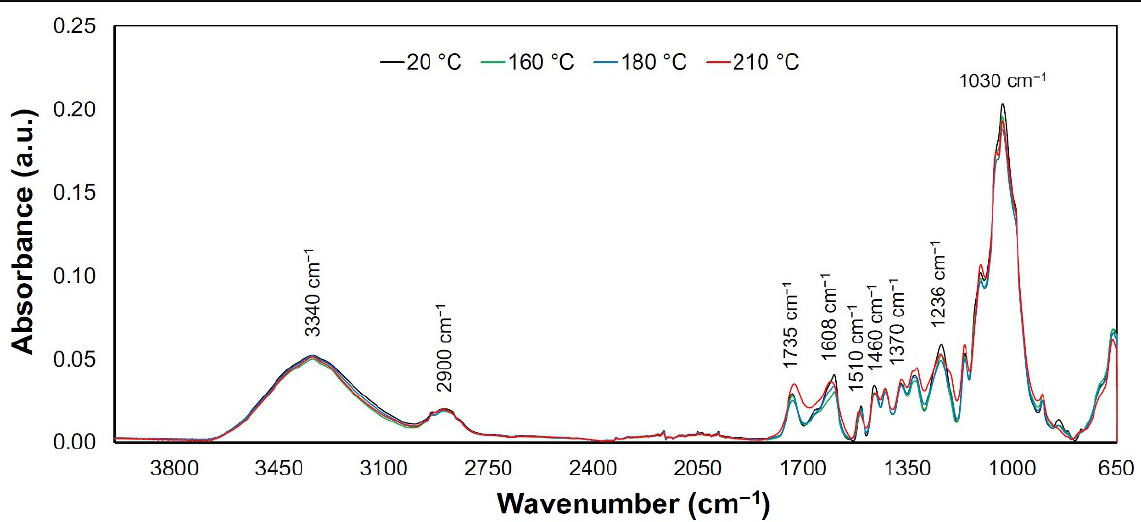
Figure 5. FTIR spectra of untreated and thermally treated black locust wood. The height of each bar in differential FTIR spectra (Figure 6) represents the difference between the absorbance of a given band of the thermally treated sample and that of the reference sample for a given wavenumber. Positive values mean an increase, and negative values mean a decrease in